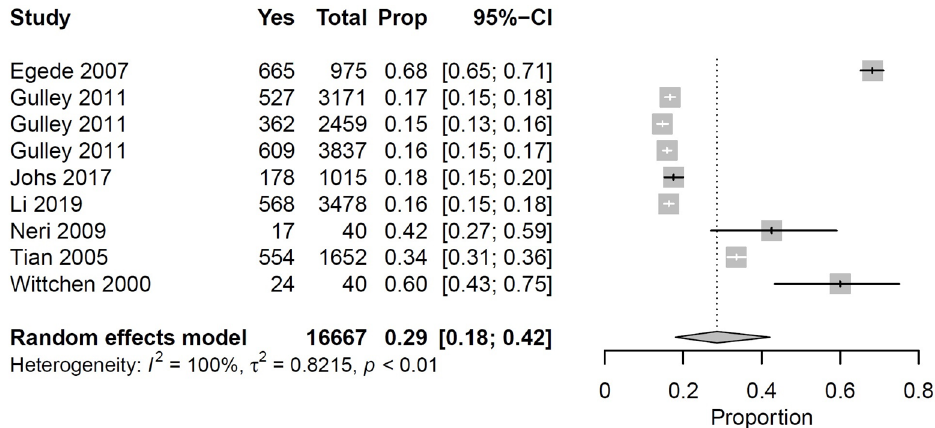
Figure 1. Forest plot shows the percentage of middle-aged persons with multimorbidity and physical impairment (of any kind). Gulley et al. shows results for three different subgroups of that population corresponding (from top to bottom) to persons with arthritis, diabetes and depression.